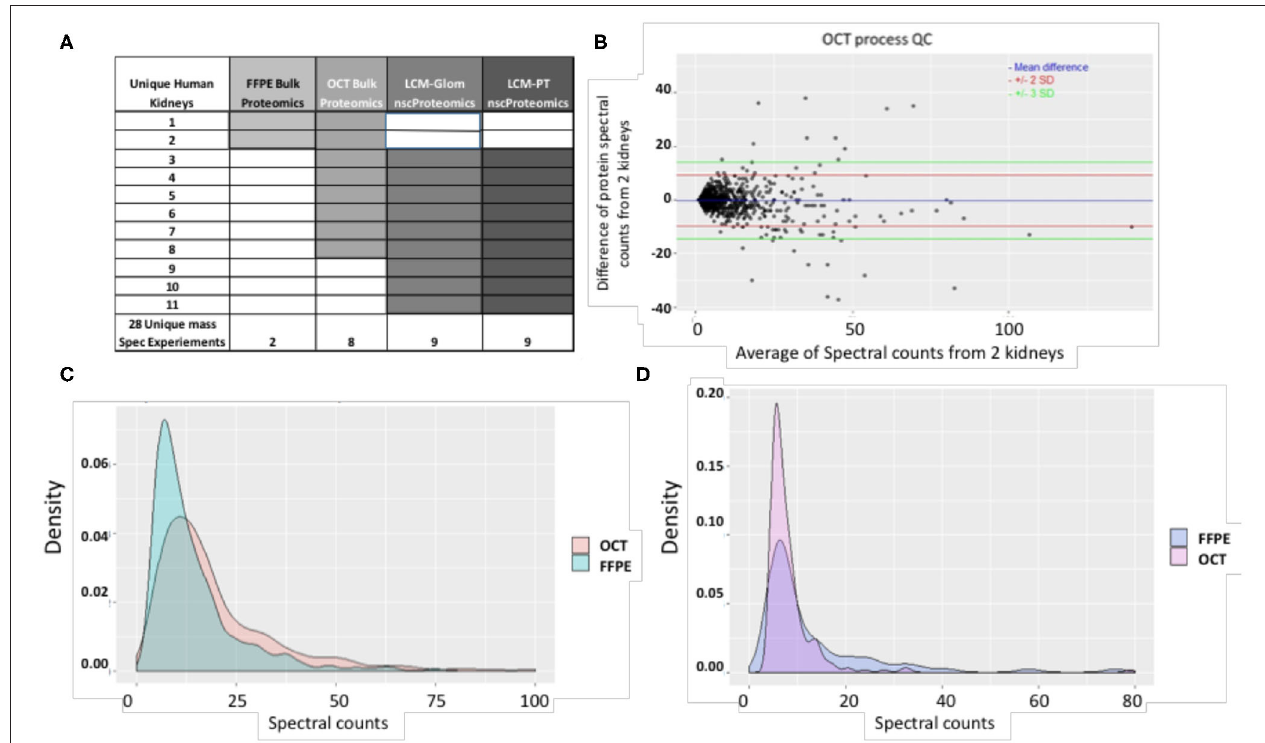
FIGURE 2 | (A) A summary of study samples and assays. (B) The QC plot for reproducibility of the process using OCT tissue. Spectral count differences between proteins for 2 separate runs using OCT tissue was plotted against average protein spectral count for 1,257 proteins. In the plot, the blue line depicts mean difference; the red and green lines depict 2 SD and 3 SD limits respectively. 97.96% of proteins are within the calculated reproducibility limit of 13.52 indicating a high degree of reproducibility. It is also seen that the inter-run variability of the process involving OCT tissue is lower than that of the process involving FFPE tissue (calculated reproducibility limit: 24.43). (C) Comparison of spectral count distributions of 374 common proteins in OCT and FFPE. Larger number of proteins from OCT tissue show high spectral counts while a higher preponderance of low spectral counts is seen for proteins from FFPE tissue. (D) Comparison of spectral count